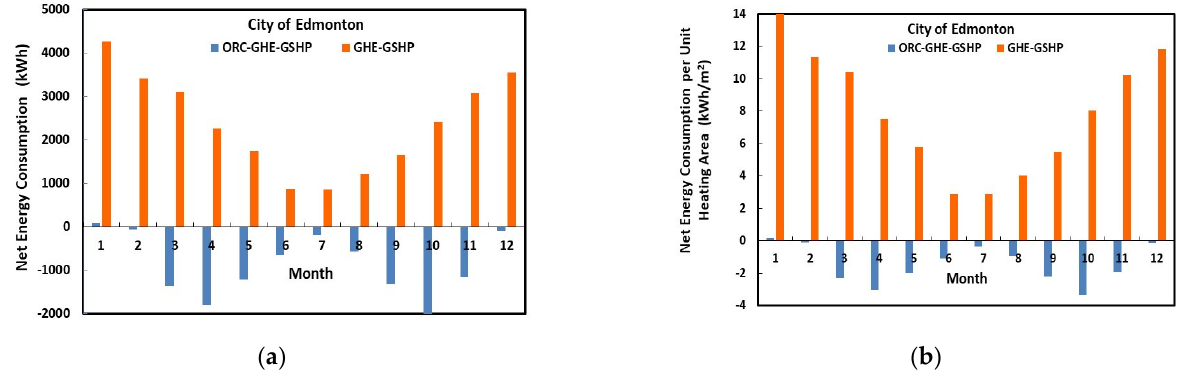
Figure 10. ( a ) Net energy consumption; ( b ) net energy consumption per unit heating area during the first year in Edmonton for ORC-GHE-GSHP and conventional GSHP systems.